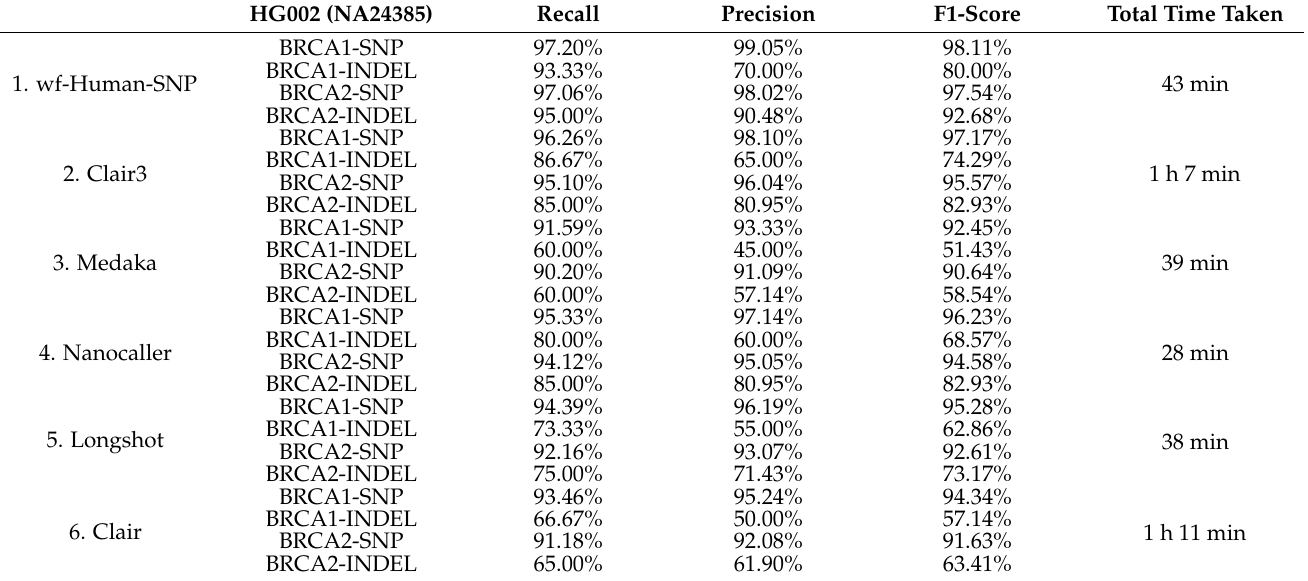
Table 6. Summary for the benchmarking output for HG002 with 6 different variant callers, highlight- ing the recall, precision, and